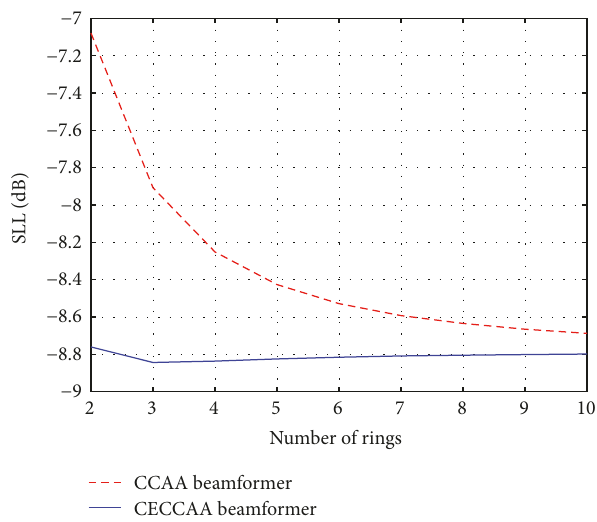
Figure 4: Variation of the SLL between the CCAA beamformer and CECCAA beamformer with the variation of the number of